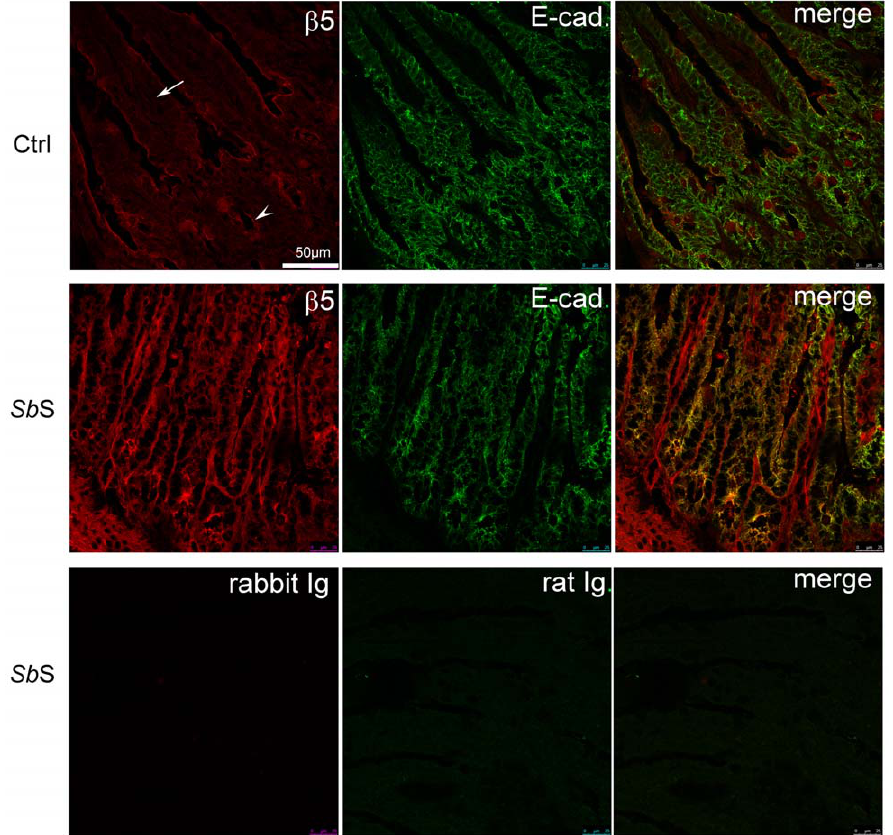
Figure 2. a v b 5 integrin is relocalized in the intestine of SbS force-fed mice. Mice were daily force-fed for one week with unused culture medium for Sb (Ctrl) or Sb S ( Sb S). Frozen sections of small intestinal tissues were co-stained with a rabbit anti- b 5- b integrin subunit ( b 5) and a rat anti E-cadherin (E-cad). Sections were then incubated with a mixture of Alexa 594-conjugated and Alexa 488-conjugated secondary antibodies against rabbit and mouse IgG, respectively. Rabbit Ig and rat Ig correspond to isotype controls Abs. Colocalized pixels appear in yellow in merged images. Each image is a representative image taken from tissue sections of four mice. The arrow and the arrowhead point out a villus and a crypt, respectively.